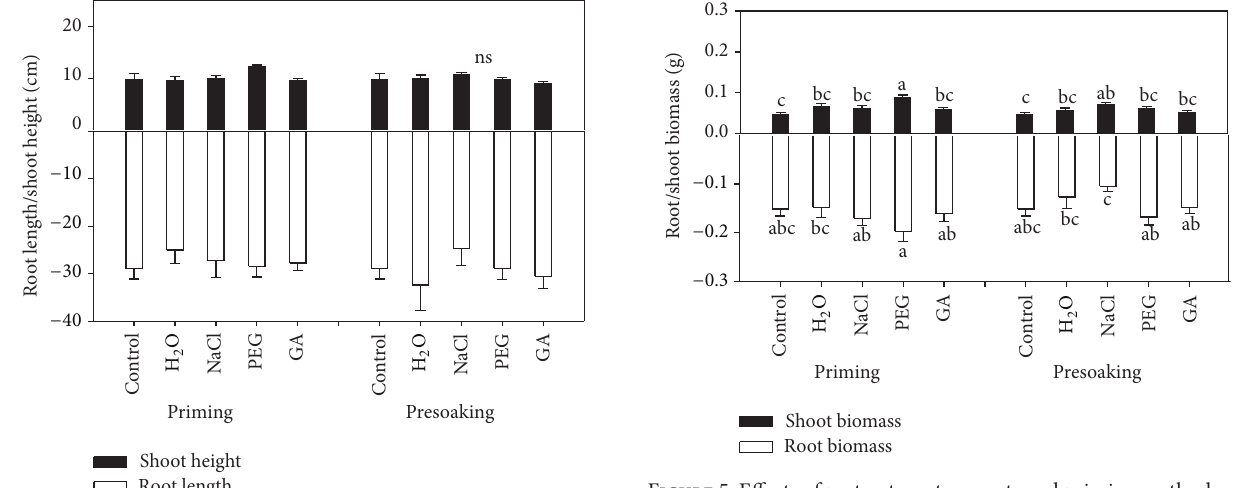
Figure 5: Effects of pretreatment reagents and priming methods on seedling shoot and root biomass of maize ( 𝑛 = 10